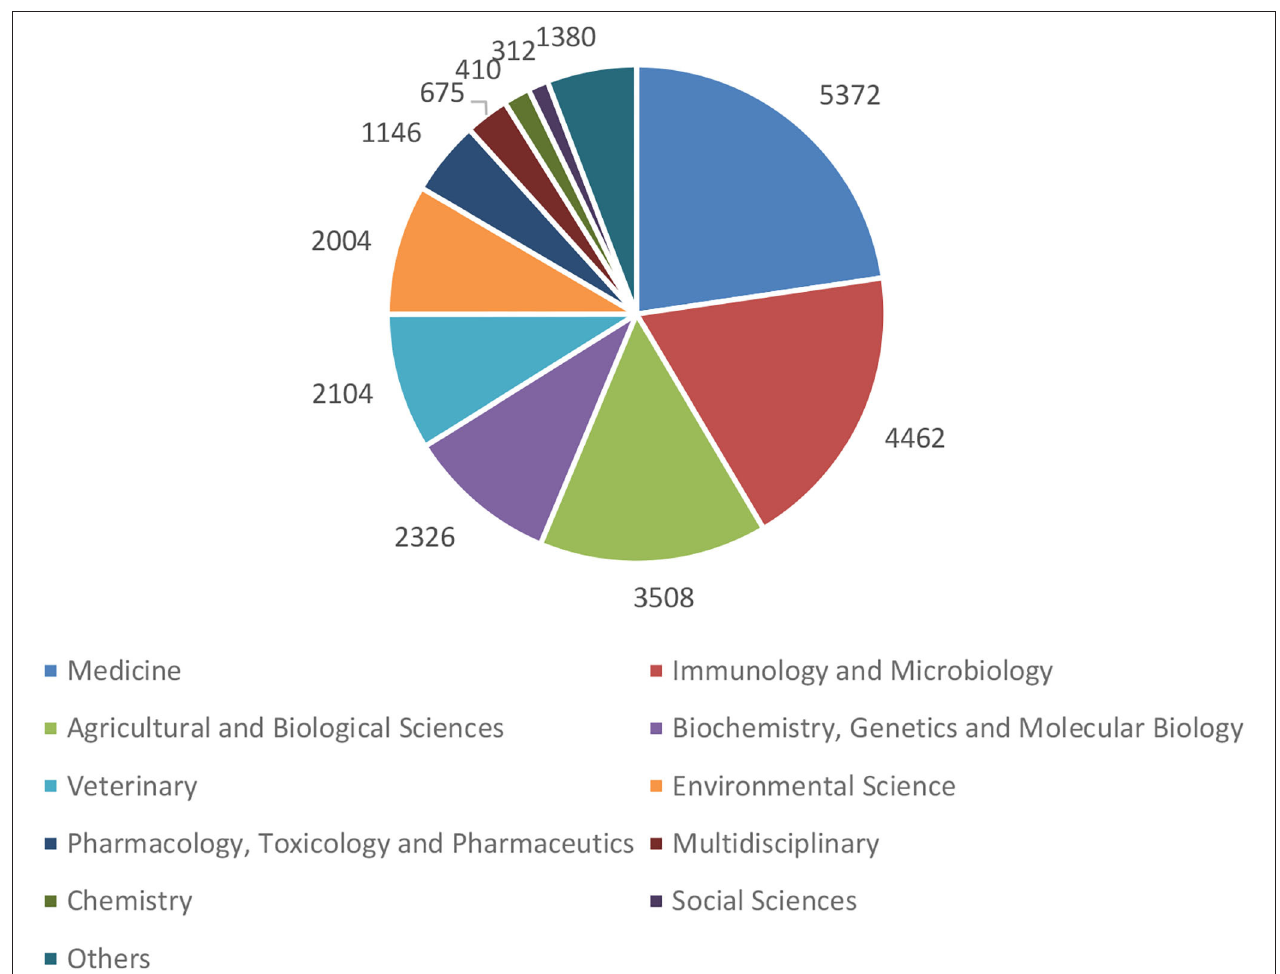
FIGURE 4 | Subject distribution of the four priority topics of One Health,